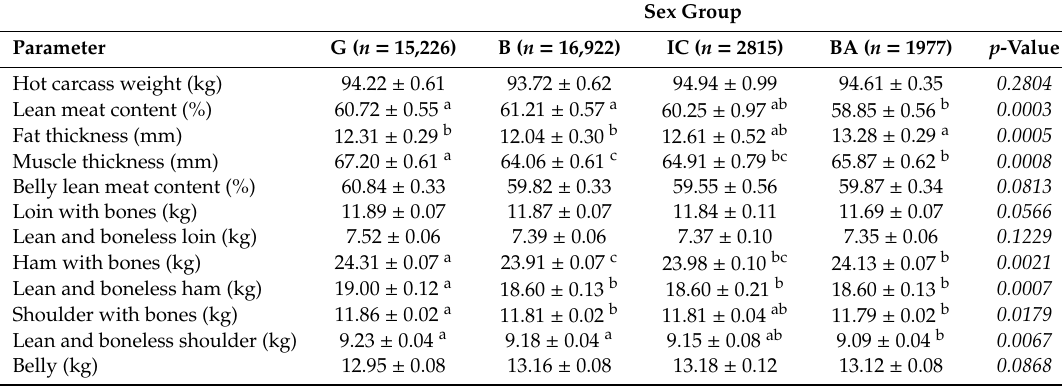
Table 2. Carcass characteristics and estimated primal pork cuts using AutoFOM III data (LSM ± SE)